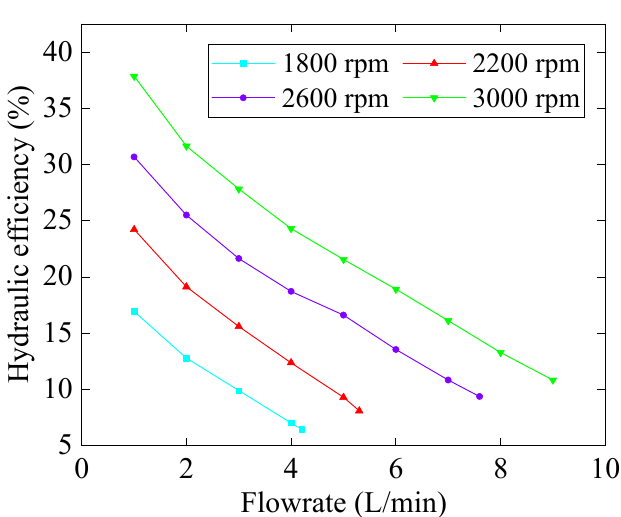
Figure 18. Hydraulic efficiency of blood pump corresponding to different speeds and flowrates.